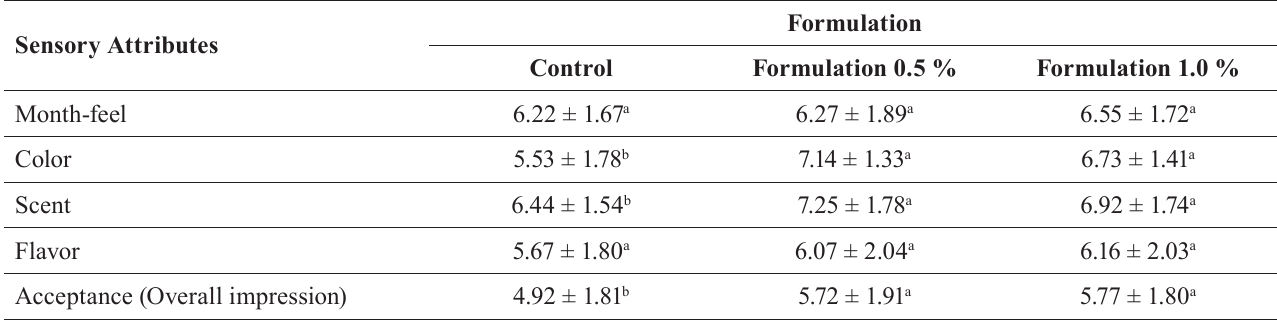
TABLE V - S ensory attributes (mean value ± standard deviation) of the hydroelectrolytic beverage formulations: Control, 0.5 % and 1.0 %